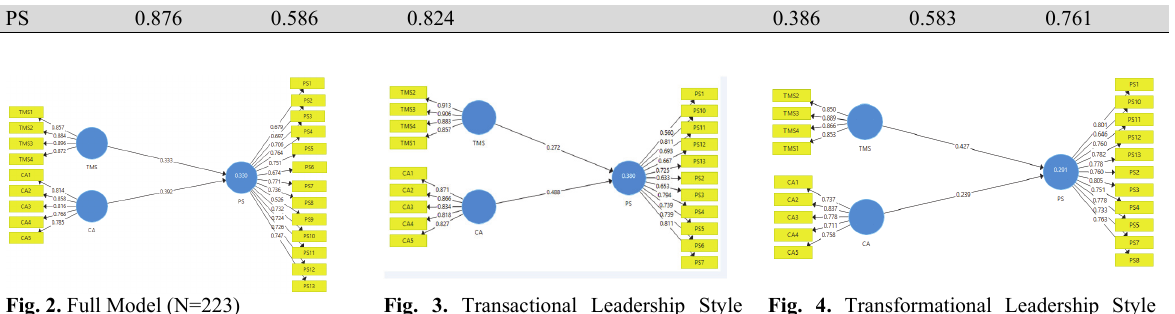
Fig. 4. Transformational Leadership Style